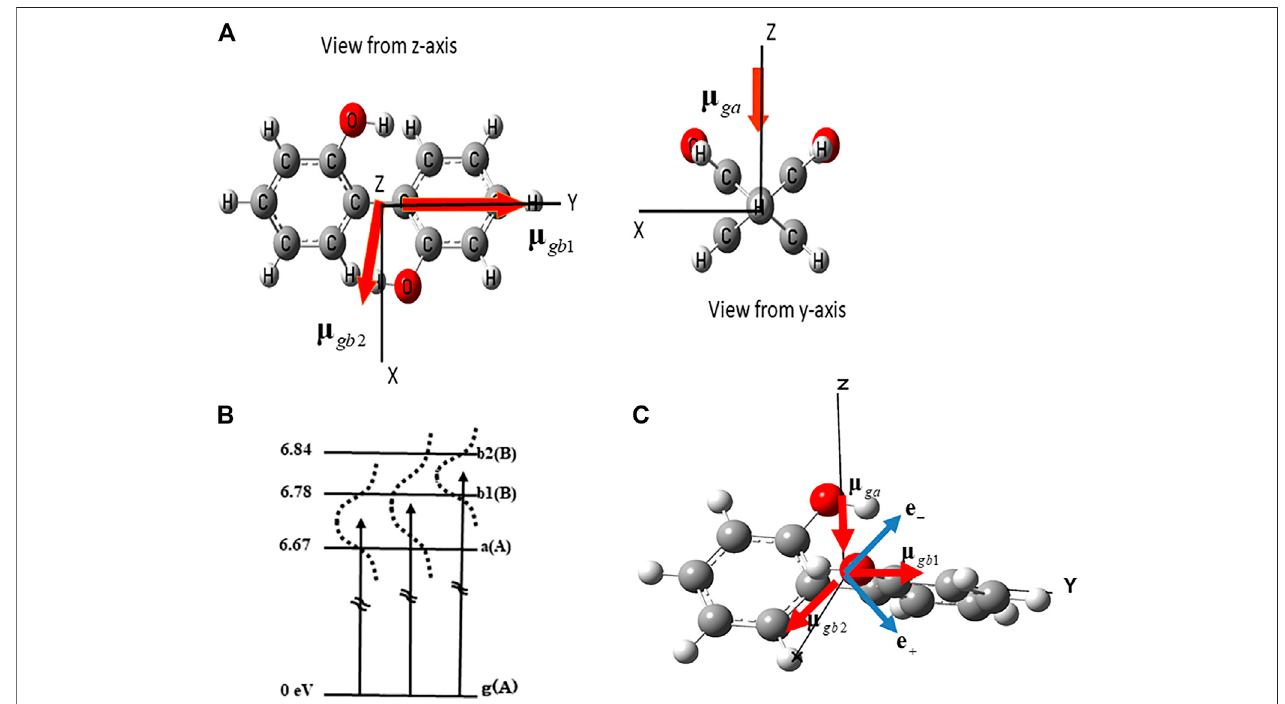
FIGURE 2 | (A) Geometrical structure of ( P )-2,2 ’ -biphenol belonging to point group C 2 and the transition dipole moments between the ground state (g) and three excitedstates a , b 1 and b 2 . (B) Threeelectronicexcitedstatesandthedipoleallowedtransitionsusedtocreatethecoherentelectronicstates.AandBaretheirreducible representations of point group C 2 . Dotted lines indicate the laser band widths that cover the superpositions of two electronic excited states (a b 1 ), (a b 2 ) and (b 1 b 2 ) respectively. (C) Linearly polarized unit vector of laser e + ( e − ) used to generate the in-phase superposition (a+b 1 ) (out-of-phase superposition (a-b 1